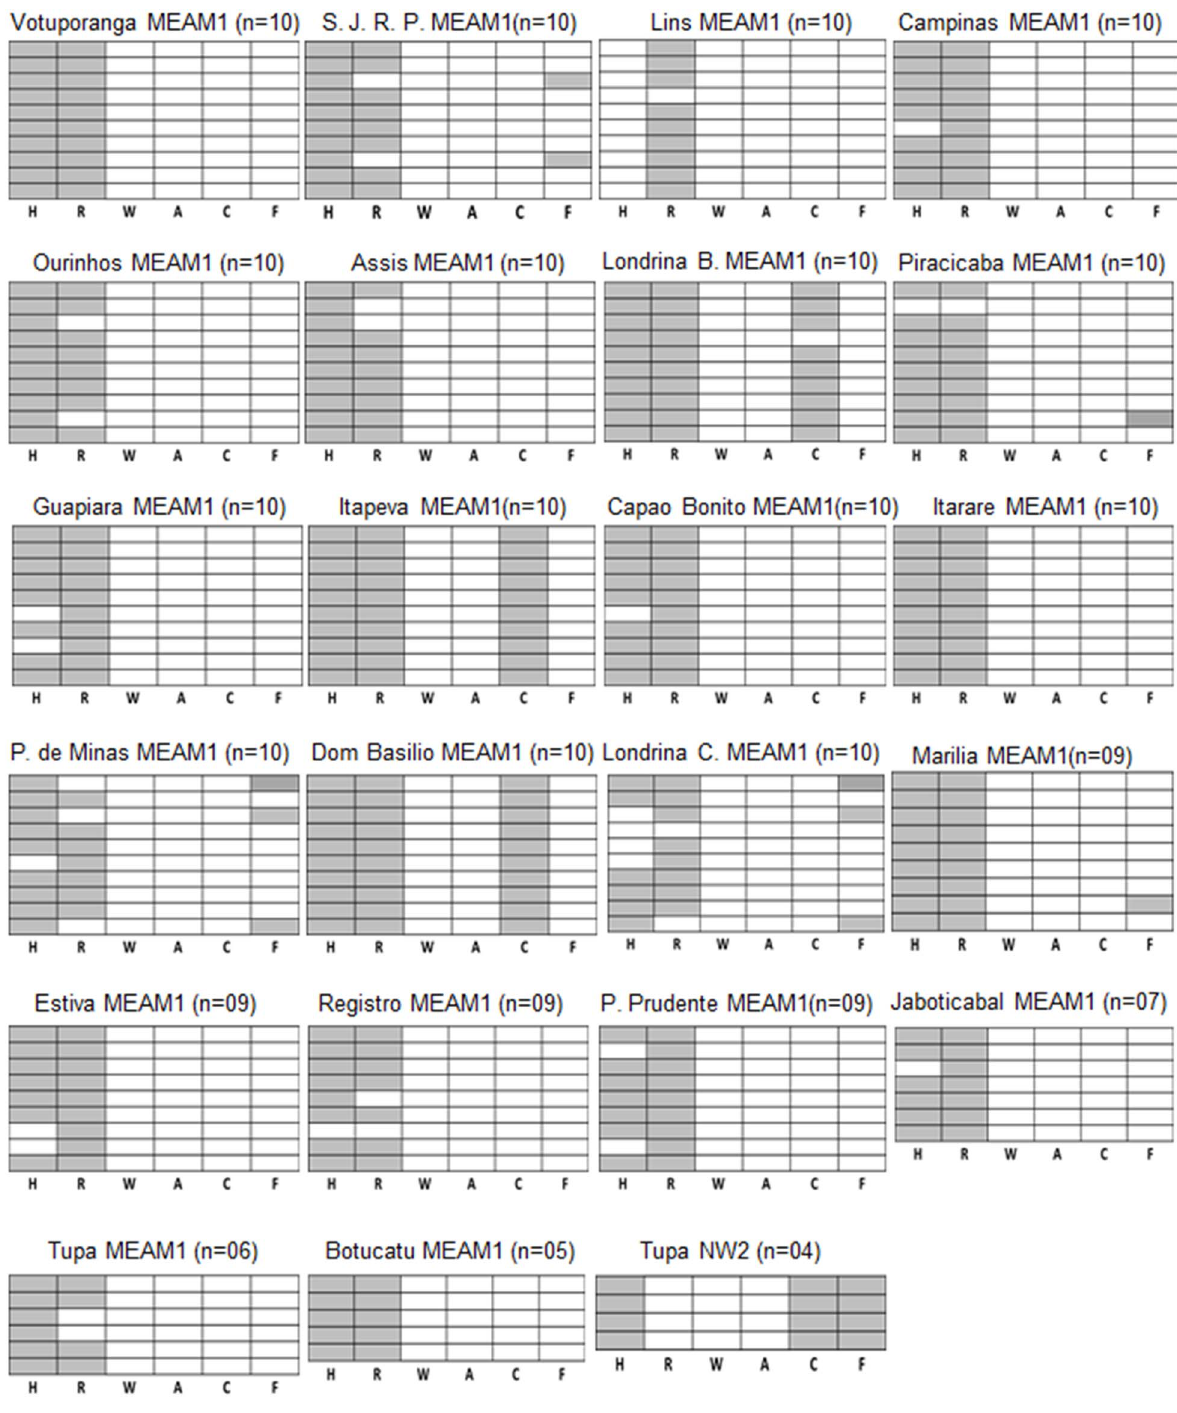
Figure 1. Individual and mixed infection by secondary symbionts in B.tabaci populations collected in this study. Twenty two MEAM1 (B biotype) and one NW2 (A biotype) populations were collected and surveyed. Each box represents one population. Vertical columns represent the different symbionts tested as indicated in the base of each column, and each horizontal column represents one individual that was tested for the presence of the six different symbionts. Shaded boxes represent positive infection with the tested symbiont. The geographical origin of the populations, the species and the number of individuals tested are indicated at the top of each box (see Table 1 for full names). doi:10.1371/journal.pone.0108363.g001 ancestor. Other symbiont strains that were shared between tuberculata and T. acaciae, and Fritschea which was also shared distantly related whitefly species collected in this study are between all whitefly species except for T. vaporariorum. Other examples included B. tuberculata infection with Wolbachia, Cardinium which was shared between MEAM1, NW2, B.